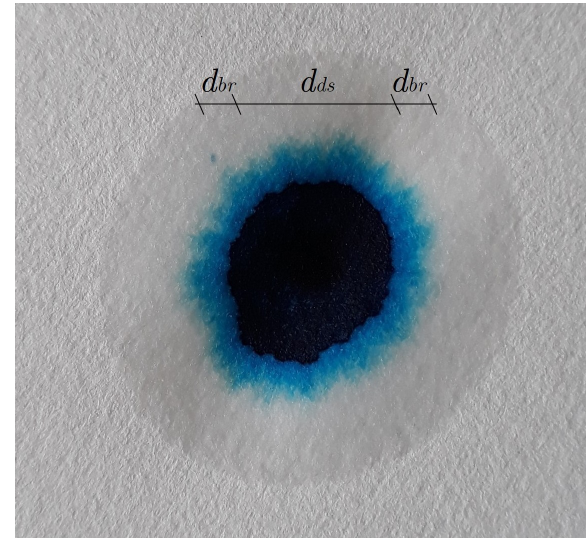
Figure 7. Distinctive light blue ring.